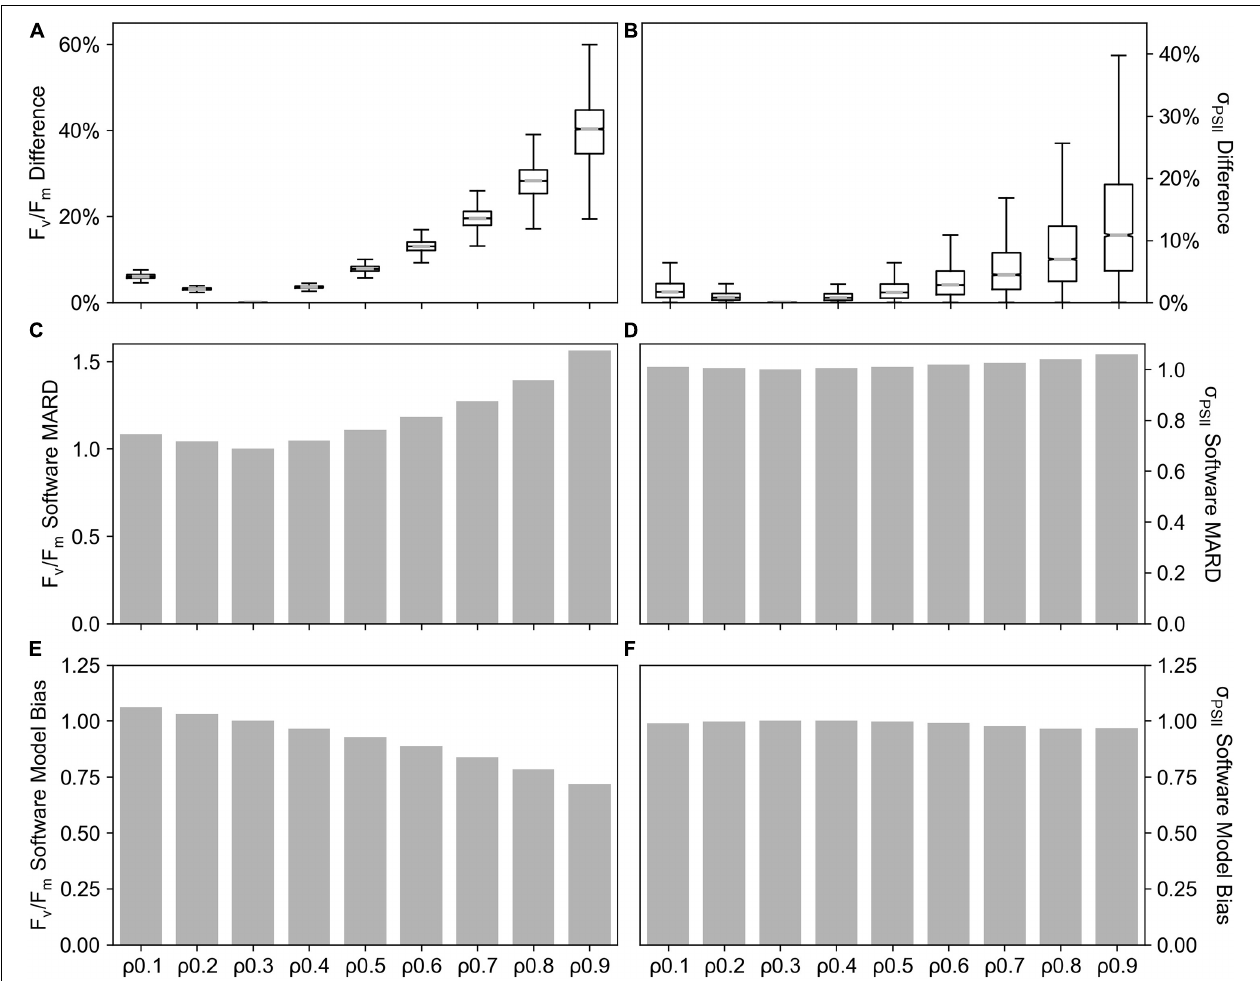
FIGURE 7 | Connectivity coefficient ( ρ ) sensitivity tests performed on the Fast Ocean data from the South Pacific (IN2016_T01). The percentage difference in F v /F m (A) an σ PSII (B) , Software MARD of F v /F m (C) , Software MARD of σ PSII (D) , Software Model Bias in F v /F m (E) and Software Model Bias in σ PSII (F) from ρ fixed at values 0.1–0.9 as compared to ρ = 0.3. Note that here, the “software” compared is PPU where ρ is fixed at values 0.10.9 as compared to PPU where ρ = 0.3.